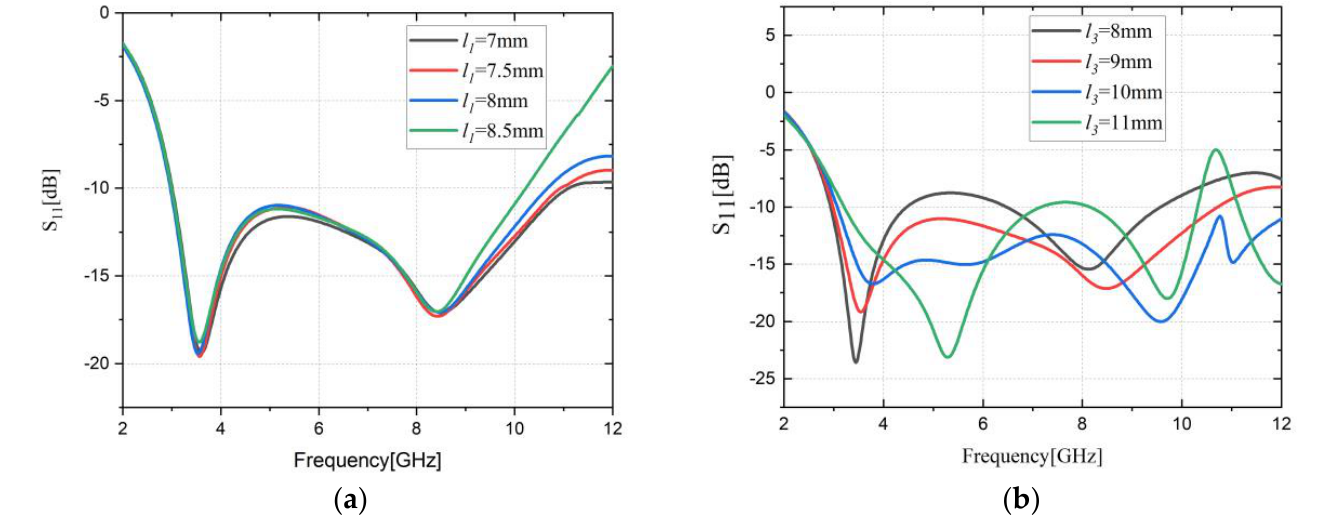
Figure 4. S11 for various sizes of ( a ) l 1 and ( b ) l 3 .